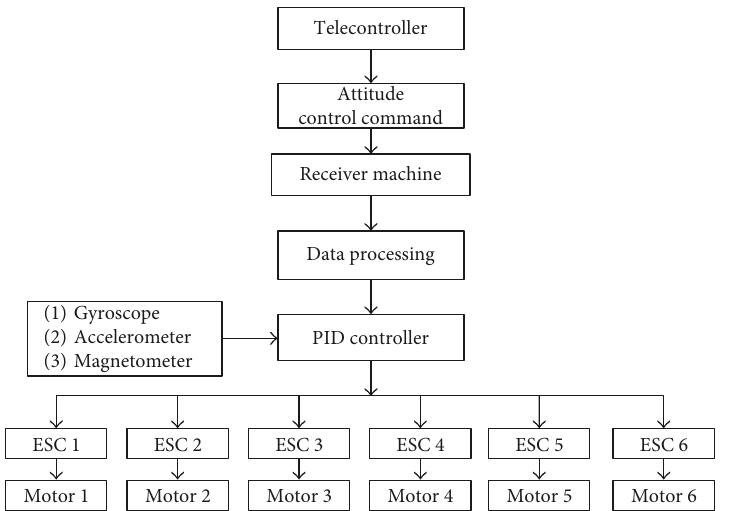
Figure 4: Six-rotor UAV system structure diagram.